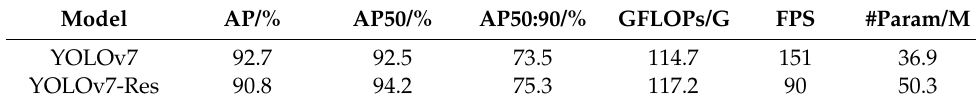
Figure 10. Results of the YOLOv7-Res3Unit ablation experiment. Table 3. Network performance of YOLOv7-Res3Unit.